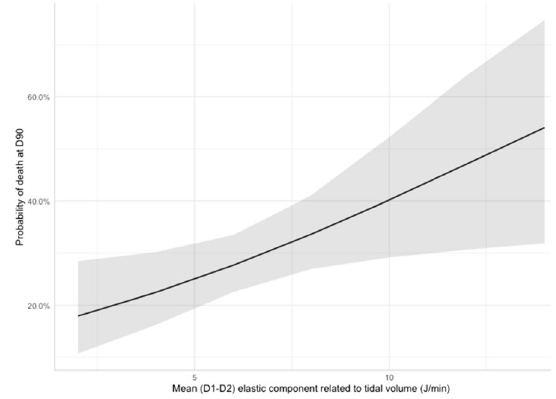
Fig. 1 Probability of death at D90 as a factor of mean value (on D1‑D2) of the elastic component related to tidal volume of the mechanical